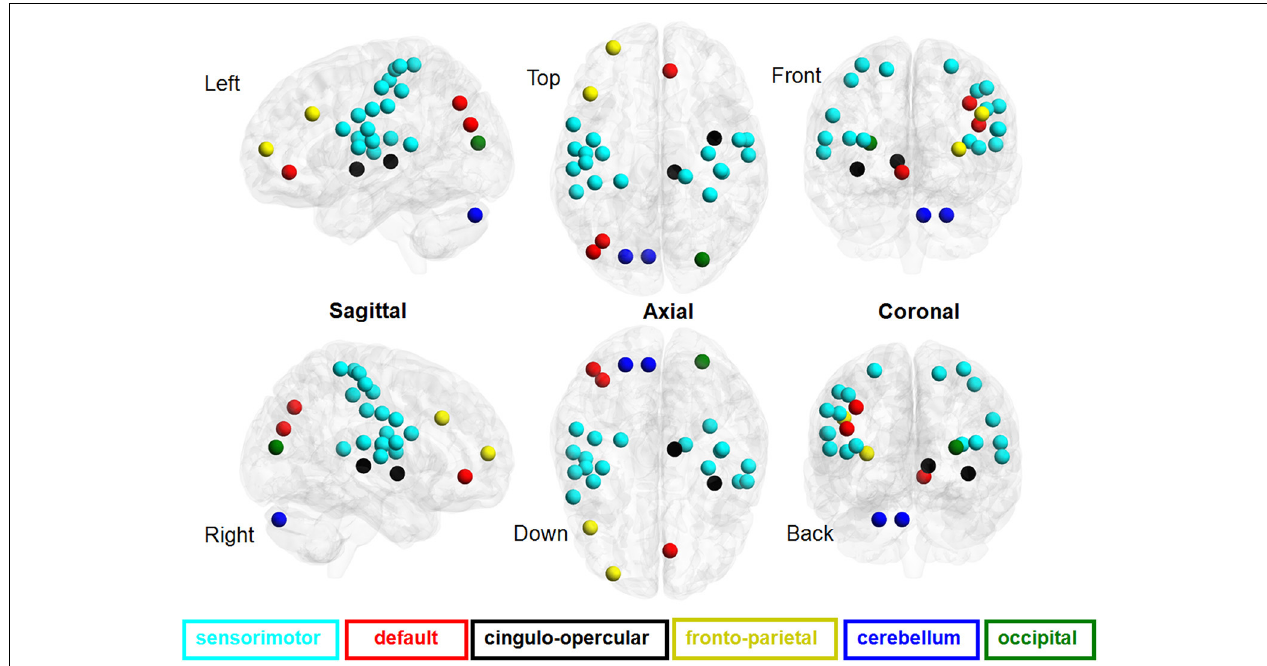
FIGURE 3 | ROC curves of the performance of SVM classifiers corresponding to different neural fALFF patterns. The yellow line corresponds to the patterns of brain regions with Z < − 1 . 96, the blue line to Z > 1 . 96, the green line to Z > 2 . 25, and the red line to | Z | > 1 . 96.